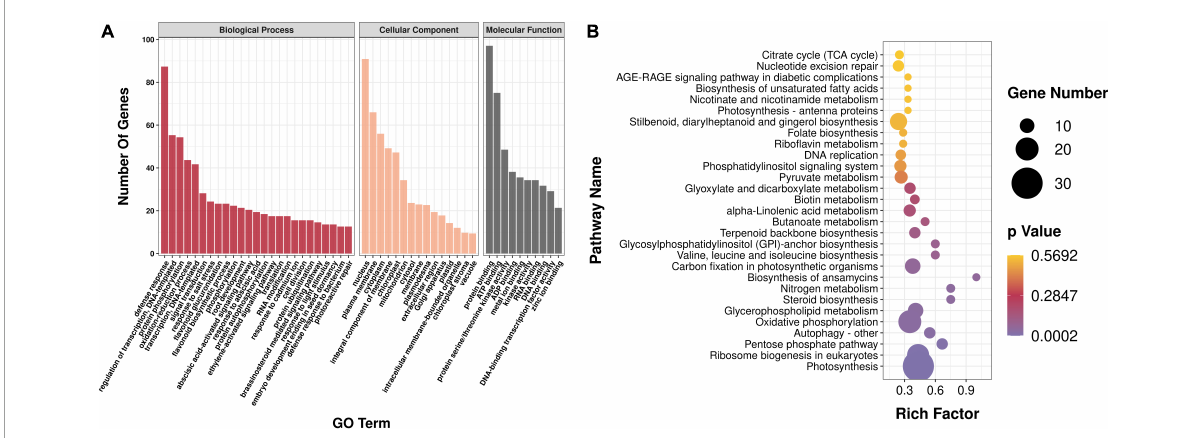
FIGURE6 Analysis of enrichment of modules. (A) GO enrichment analysis. GO, Gene Ontology. (B) KEGG enrichment analysis. KEGG, Kyoto Encyclopedia of Genes and Genomes.